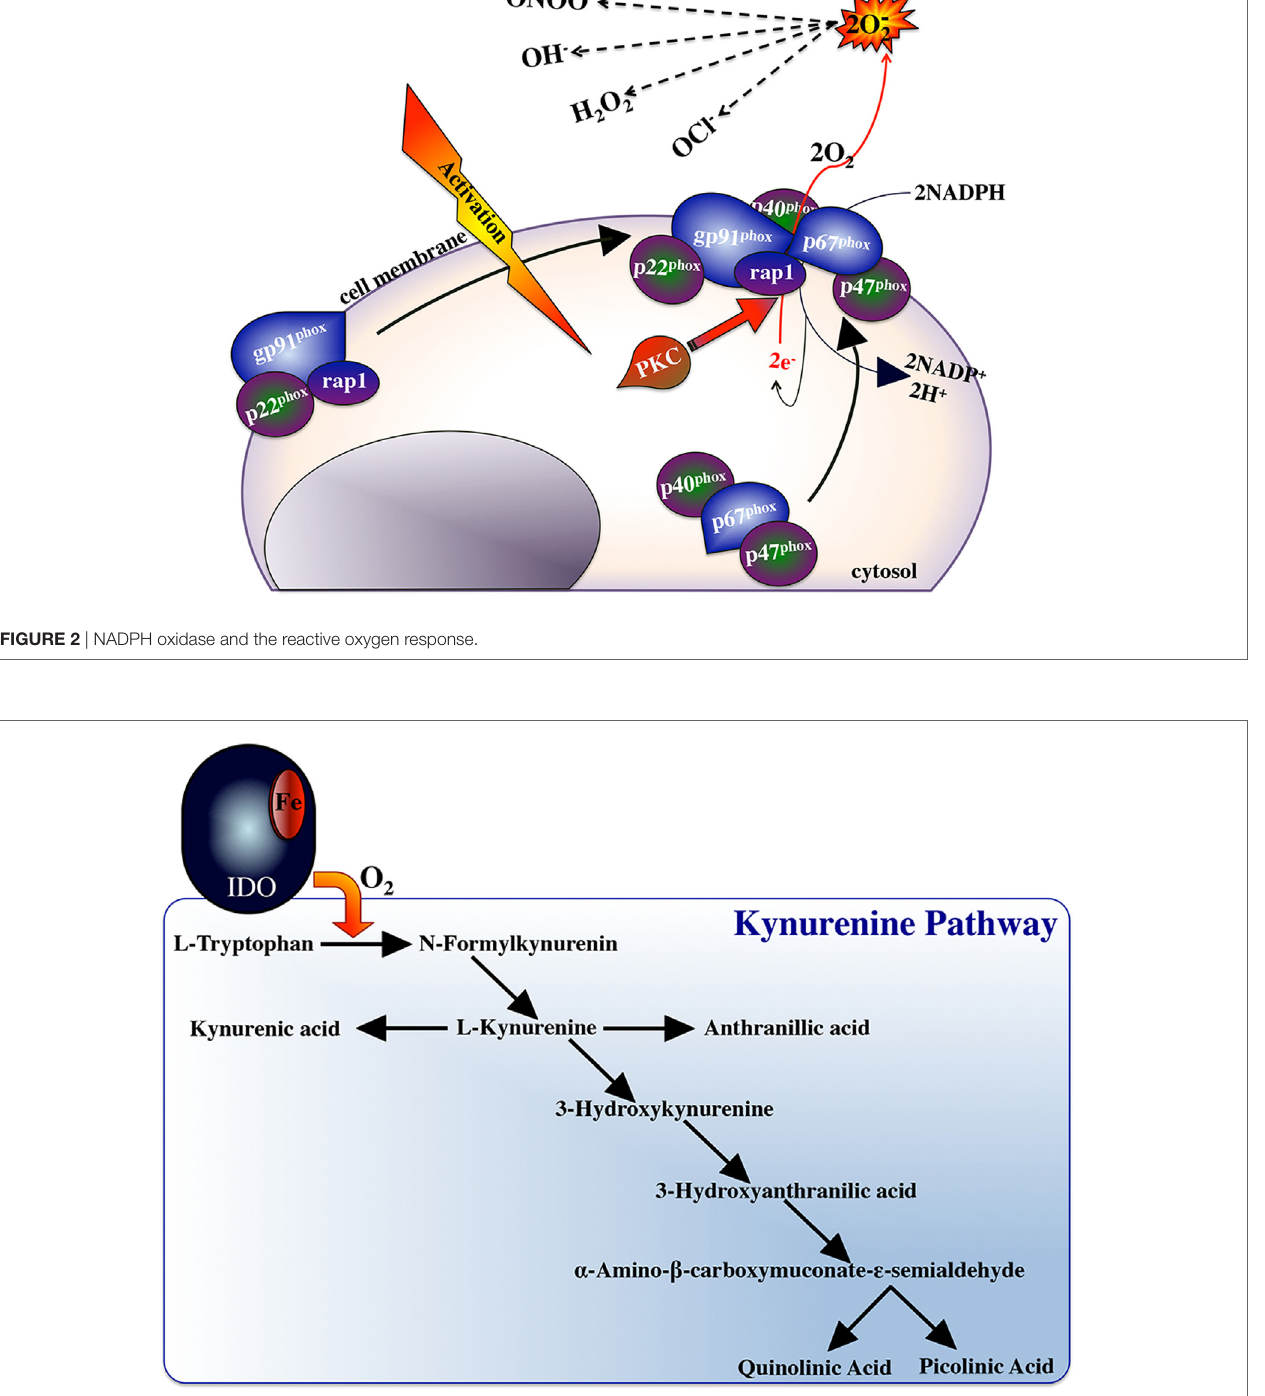
FigURe 3 | Indoleamine 2, 3 dioxygenase and the tryptophan degradation pathway.